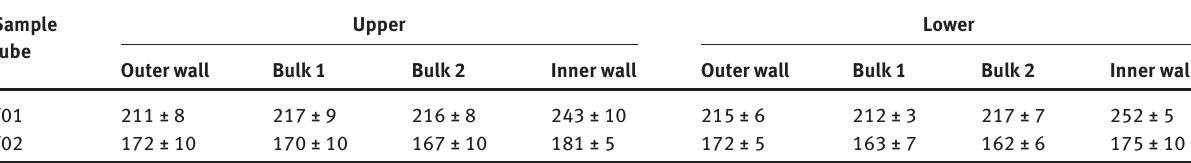
Table 13: Vickers hardness values from test results performed on the supplied materials [32]. Sample